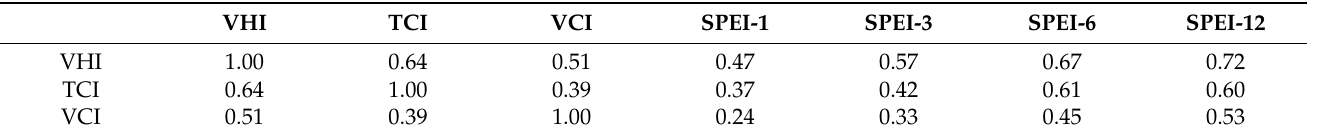
Table 5. Correlation matrix between Remote sensing and meteorological drought indices based on GEE) and stations data over the Al-Lith watershed from